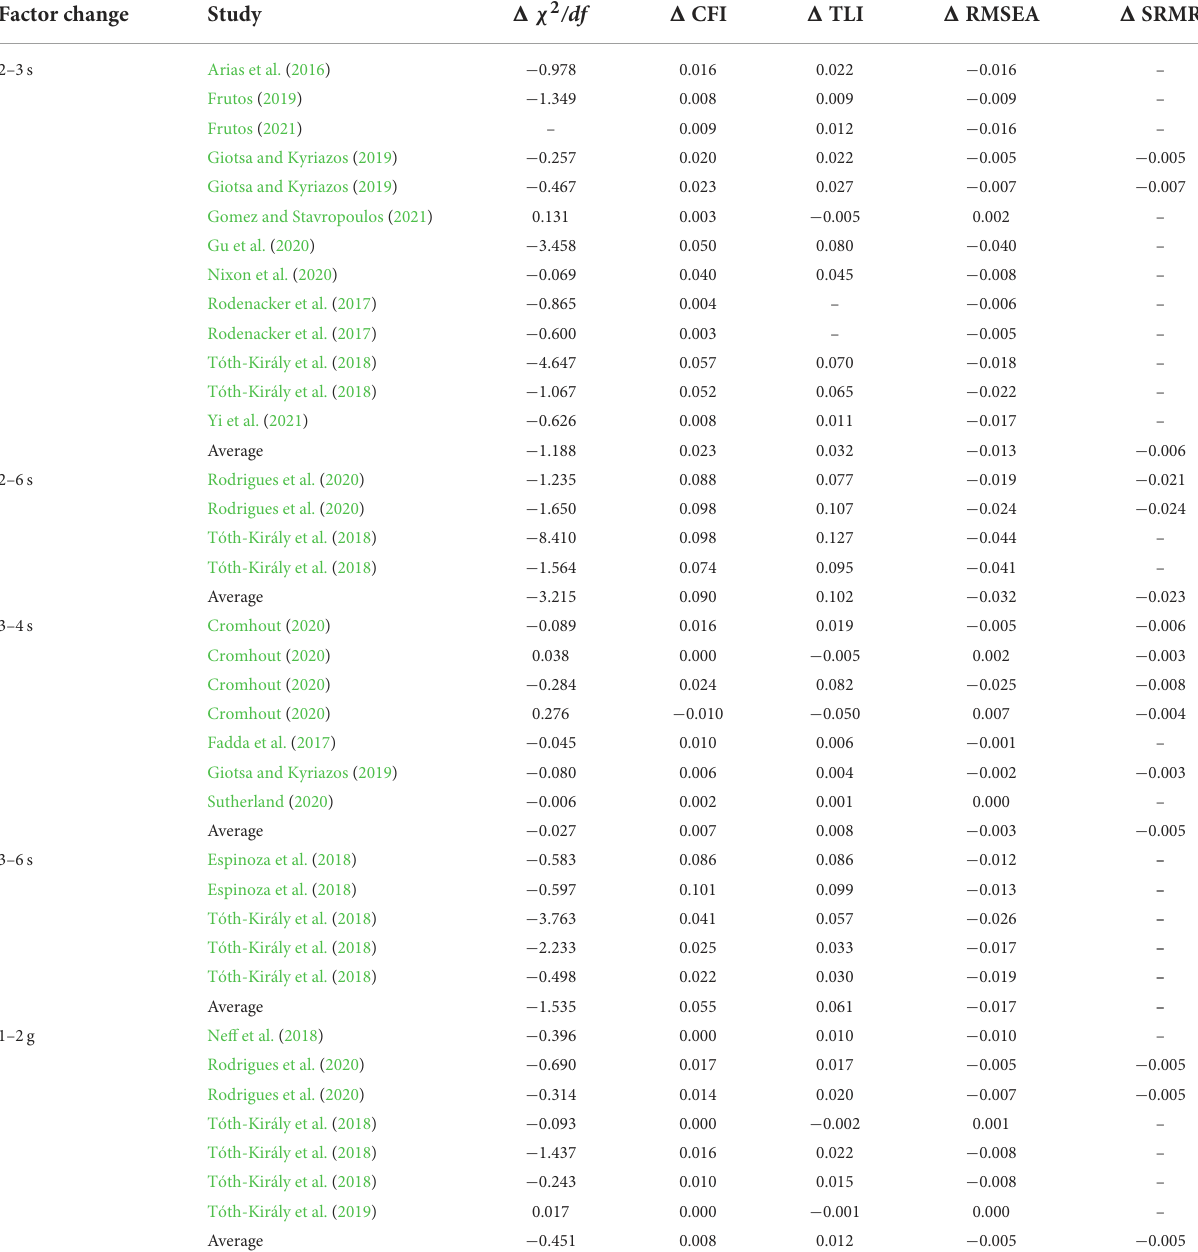
TABLE 8 Within-Study analysis of changes in B-ESEM model fit by factor number. Factor